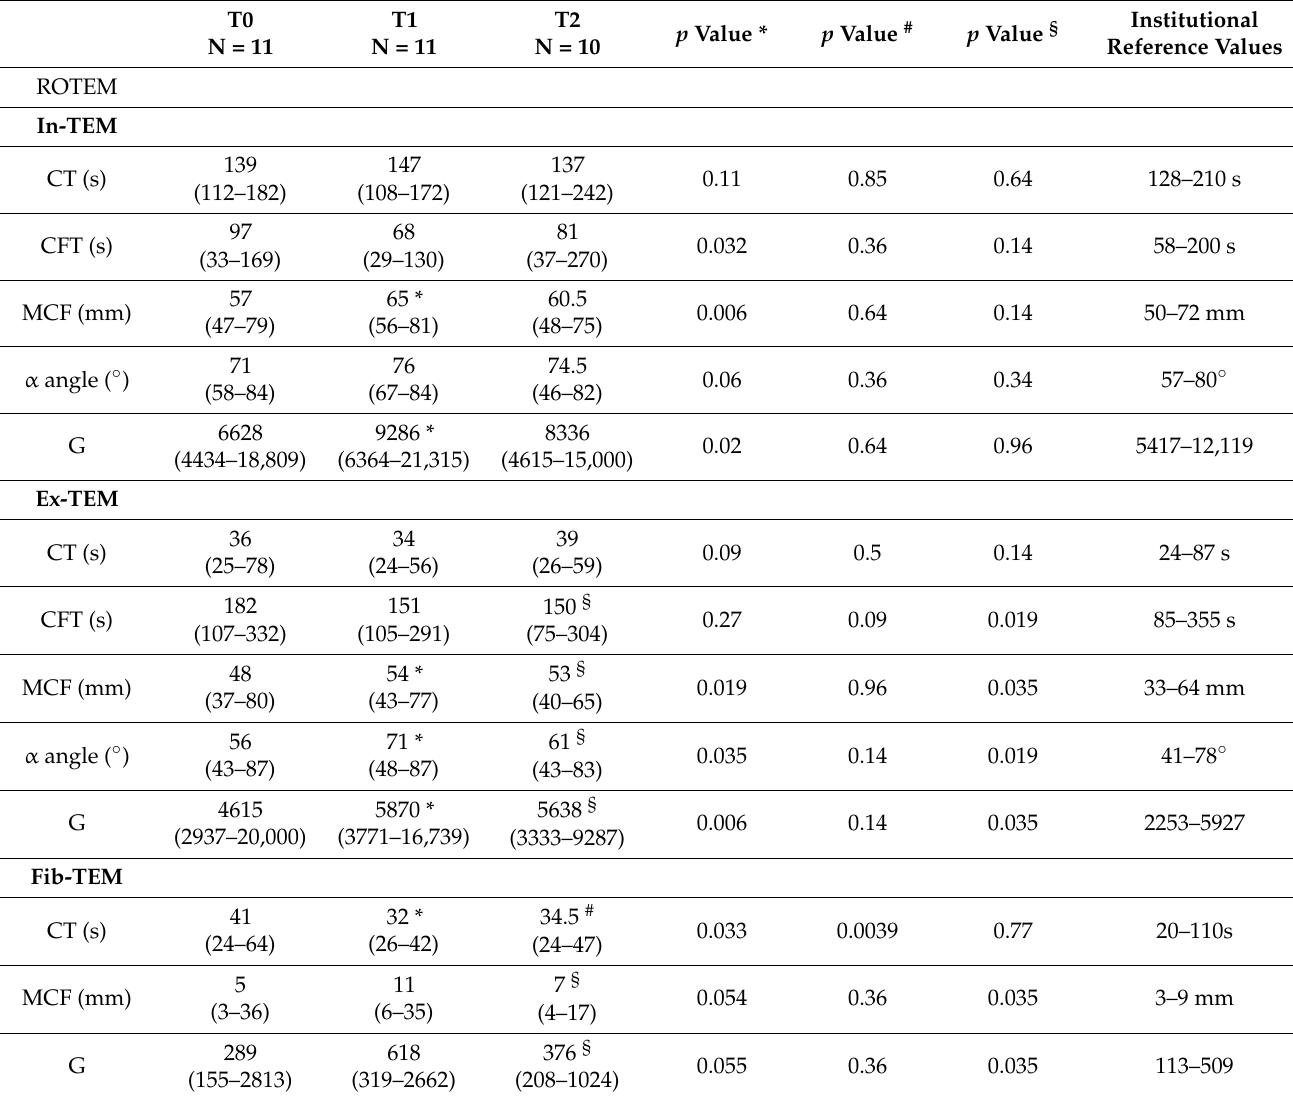
Table 1. Thromboelastometric results assessed before surgery (T0), 24 h after surgery (T1), and two weeks after surgery